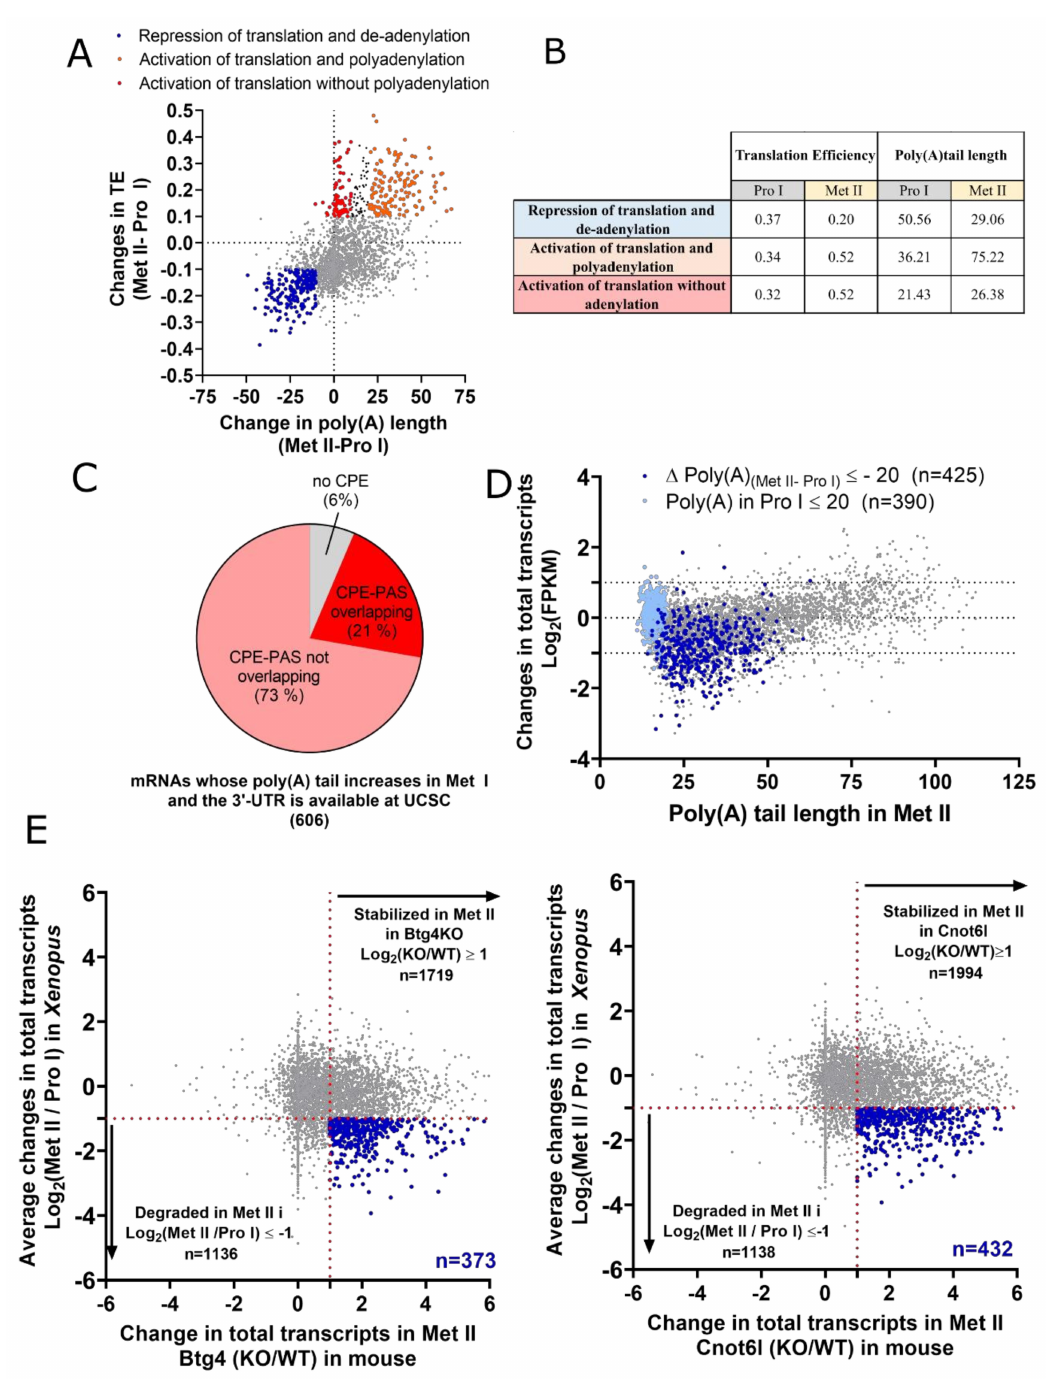
Figure 5. The relationship between poly(A) tail length, translation, and mRNA degradation. ( A ) Changes in translation e ffi ciency (TE) and in the poly(A) tail length between fully-grown prophase (Pro I) and metaphase II (Met II) oocytes [72]. Transcripts are divided into three groups: transcripts whose poly(A) tail decreases, at least, by 10 nt and TE decreases, at least, by 0.1 (blue—repression of translation and de-adenylation), transcripts whose poly(A) tail increases less than 10 nt and TE increases more than 0.1 (red—activation of translation without polyadenylation), and mRNAs